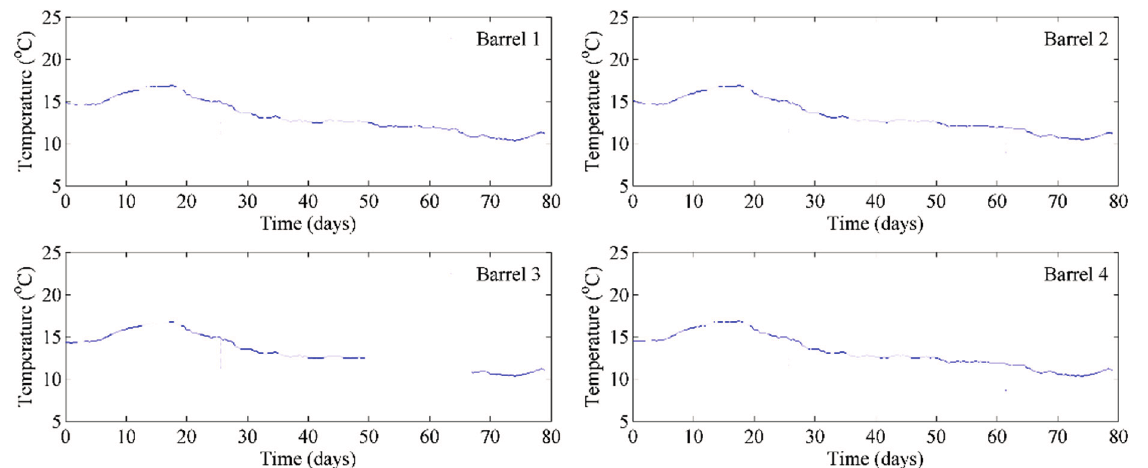
Figure 4. Continual monitoring of temperature of four barrels of wine in